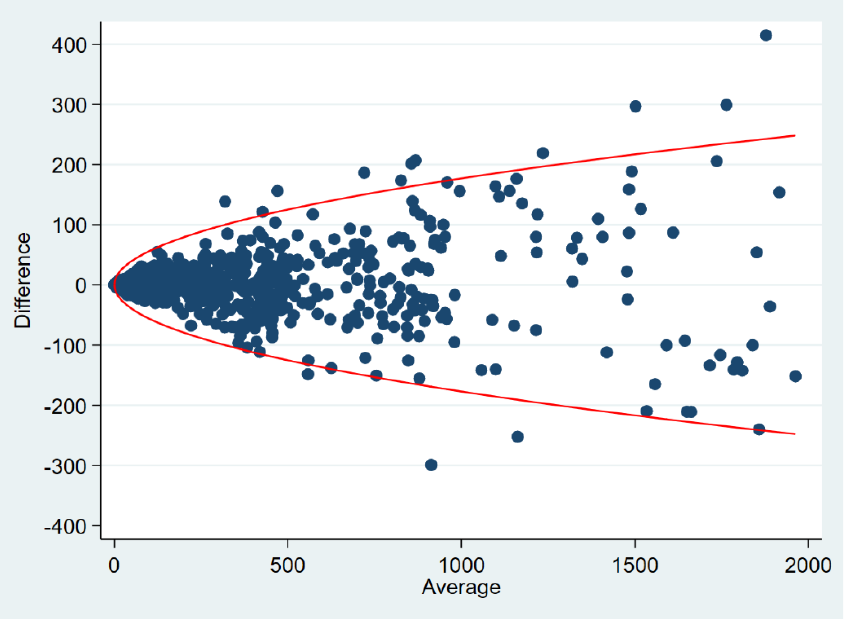
Figure 3. Plot shows a fictive distribution of differences between repeated Agatston scores. Curve shows 95% repeatability limits based on nonparametric quantile regression as applied in